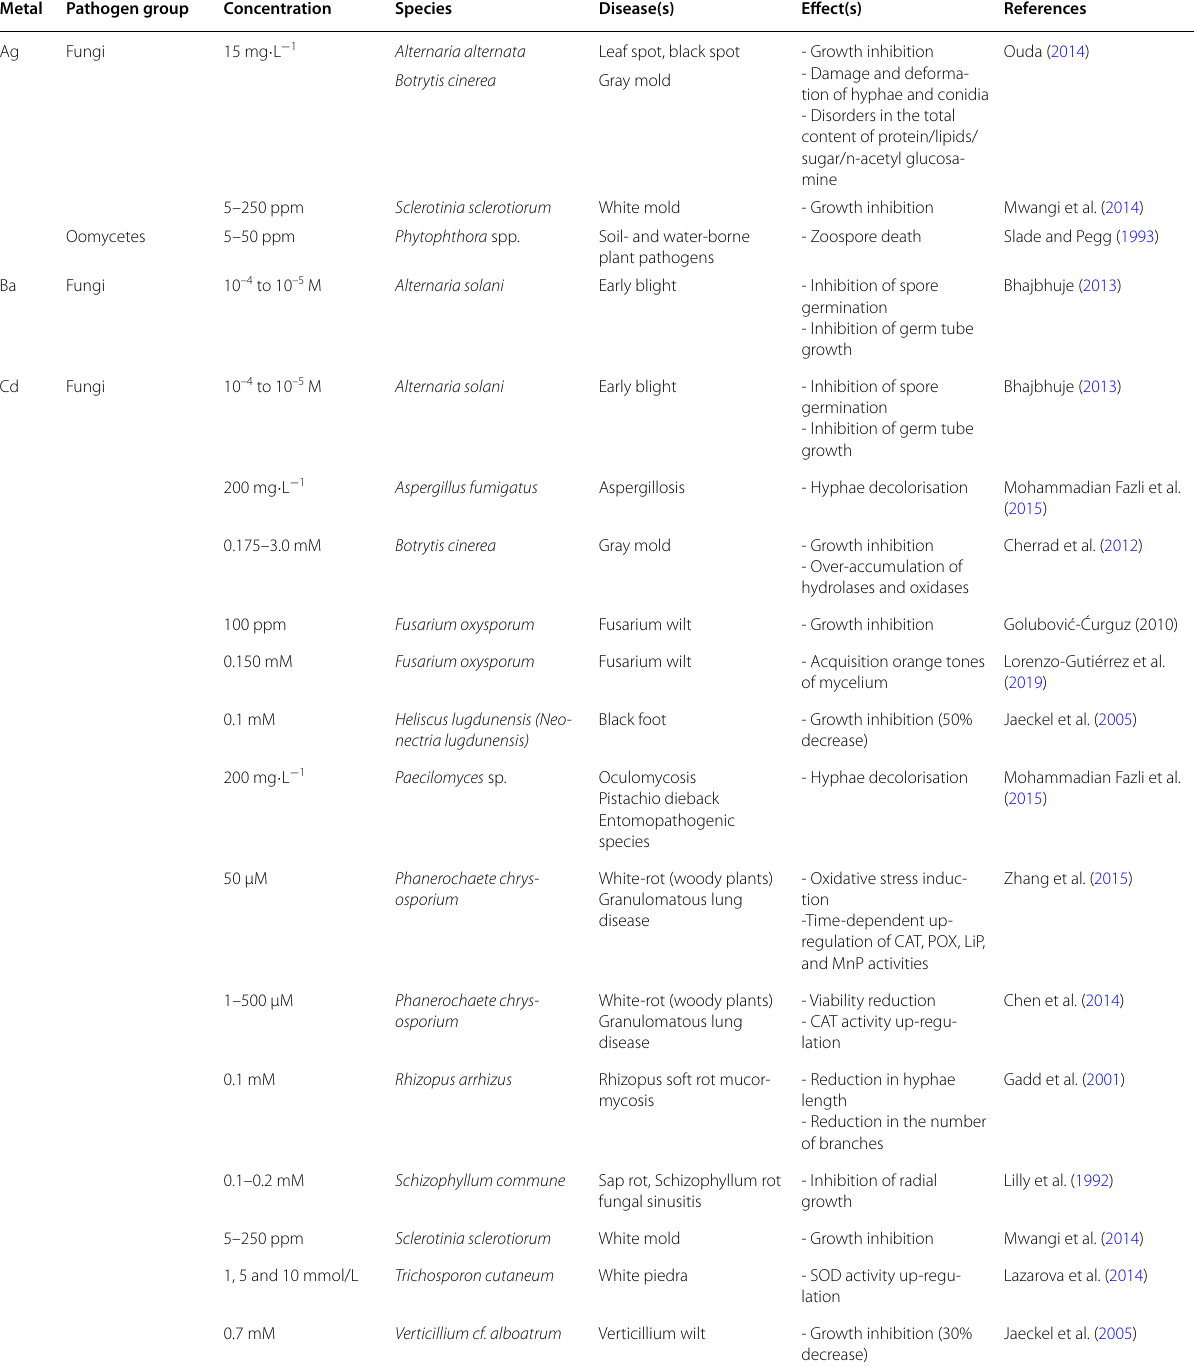
Table 1 The toxic effect of HMs on filamentous pathogens Metal Pathogen